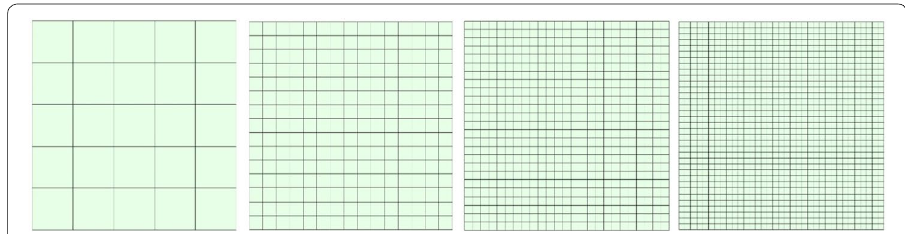
Fig. 4 Finite element meshes used, namely Mesh1 (left), Mesh2 (centre left), Mesh3 (centre right) and Mesh4 (right)